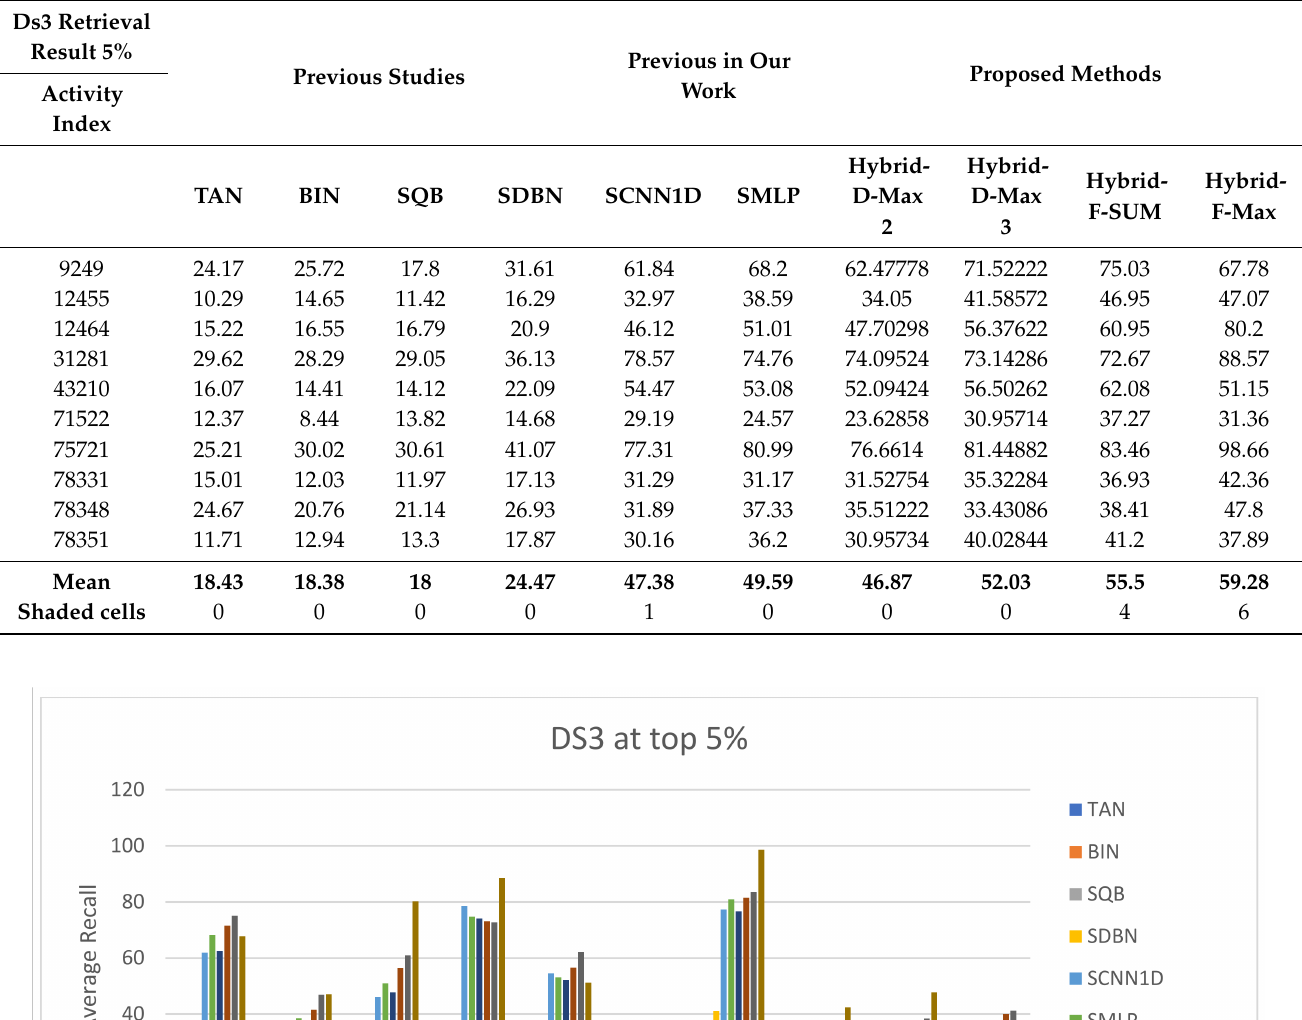
Table 10. Top 5% retrieval recall for MDDR-DS3 (structurally heterogeneous) dataset for descriptor (ECFC 4).